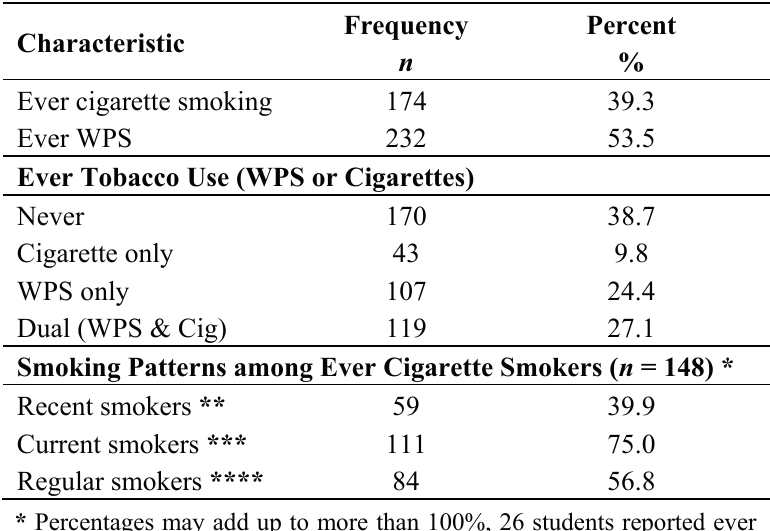
Table 1. Participants’ self-report smoking characteristics ( n =